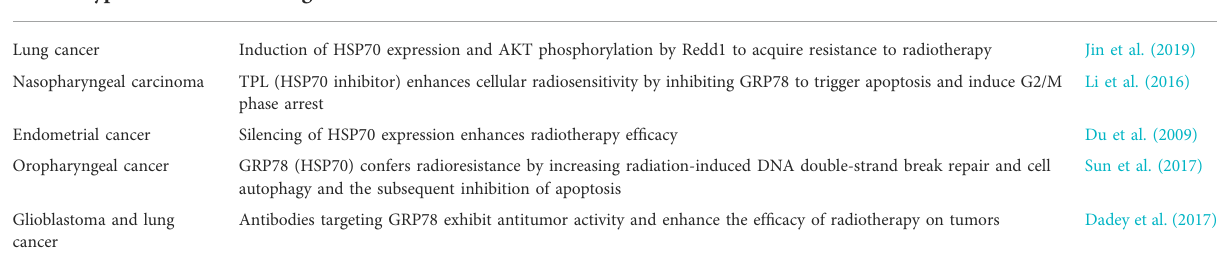
TABLE 1 The role of HSP70 in resistance to